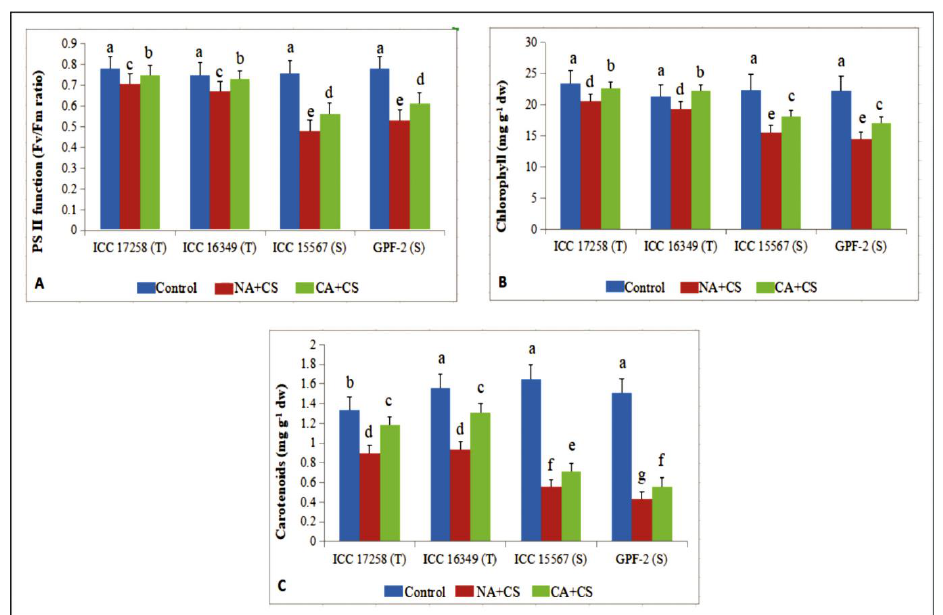
Figure 3. Photosystem II function (PS; ( A )), chlorophyll (Chl; ( B )) and carotenoids (Car; ( C )) in leaves of control, non-acclimated, cold stressed; NA + CS) and cold-acclimated, cold stressed (CA + CS) plants of tolerant (T) and sensitive (S) genotypes. Small vertical bars represent standard errors (Mean ± S.E; n = 3). Different small letters on vertical bars indicate significant differences from each other ( p < 0.05; Tukey’s test). Least significant difference (LSD) for interaction ( p < 0.05) (genotypes × treatments): PS (0.057), Chl (2.5), Car (0.056).